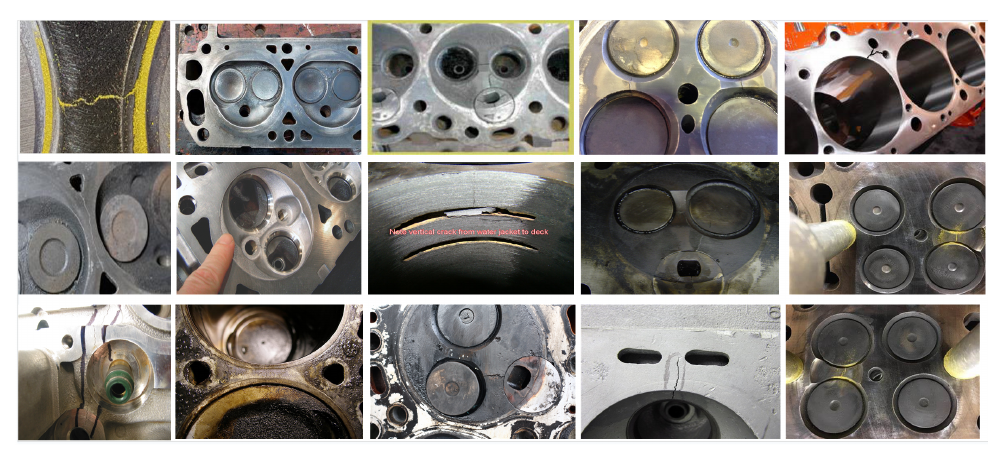
Figure 7. Sample of automotive engine component images from Berwo et al. [4]. Table 2. Detailed parameters of the proposed